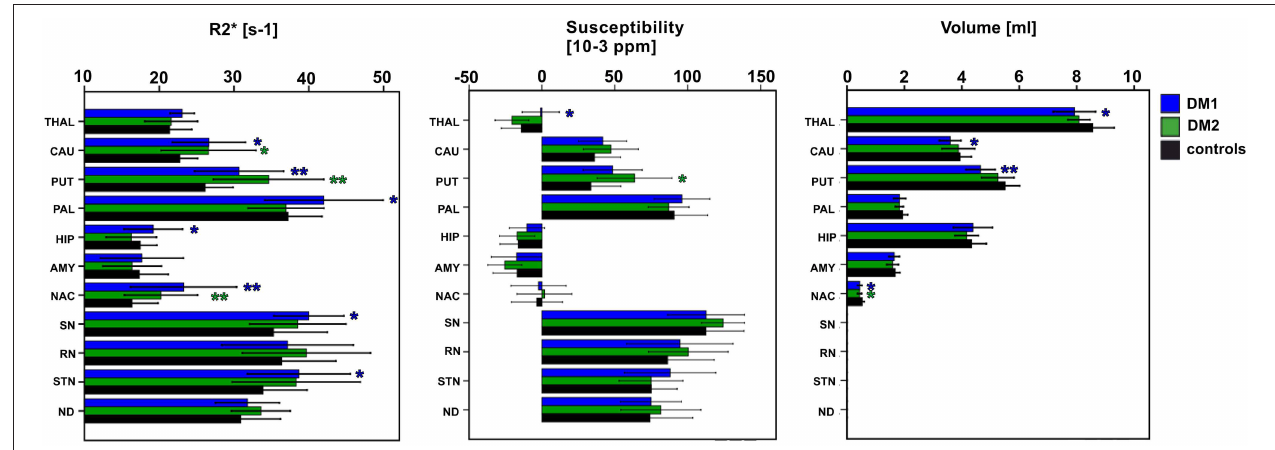
FIGURE 2 | Group comparisons between classical DM1, DM2, and healthy controls (entire control group) for DGM nuclei: THAL, thalamus; CAUD, caudate; PUT, putamen; PAL, pallidum; HIP, hippocampus; AMY, amygdala; NAC, N. accumbens; SN, substantia nigra; RN, red nucleus; STN, subthalamic nucleus; ND, dentate nucleus. Boxes, error bars: mean ± 1 standard deviation. Significance of group differences compared to age matched healthy controls: * P < 0.050, ** P < 0.010.